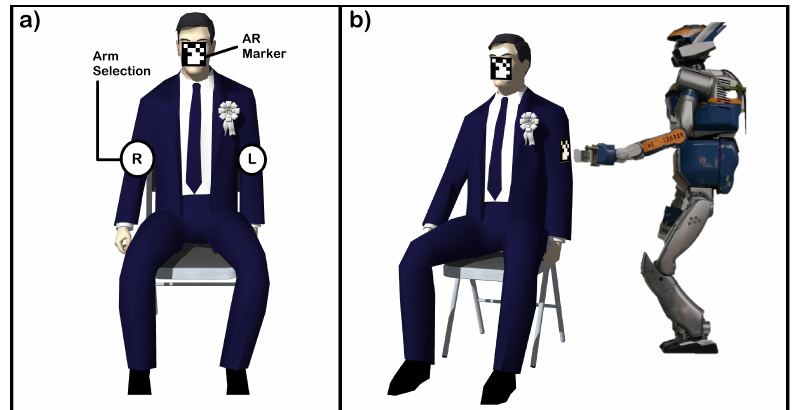
Figure 13. ( a ) SSVEP for arm selection and ( b ) interaction phase (selected arm is touched).